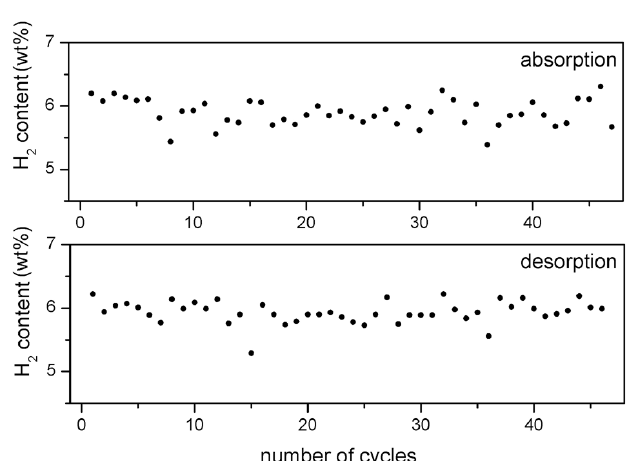
storage capacity of 5 wt% Fe-doped MgH Figure 3. H 2 desorption cycle versus number of